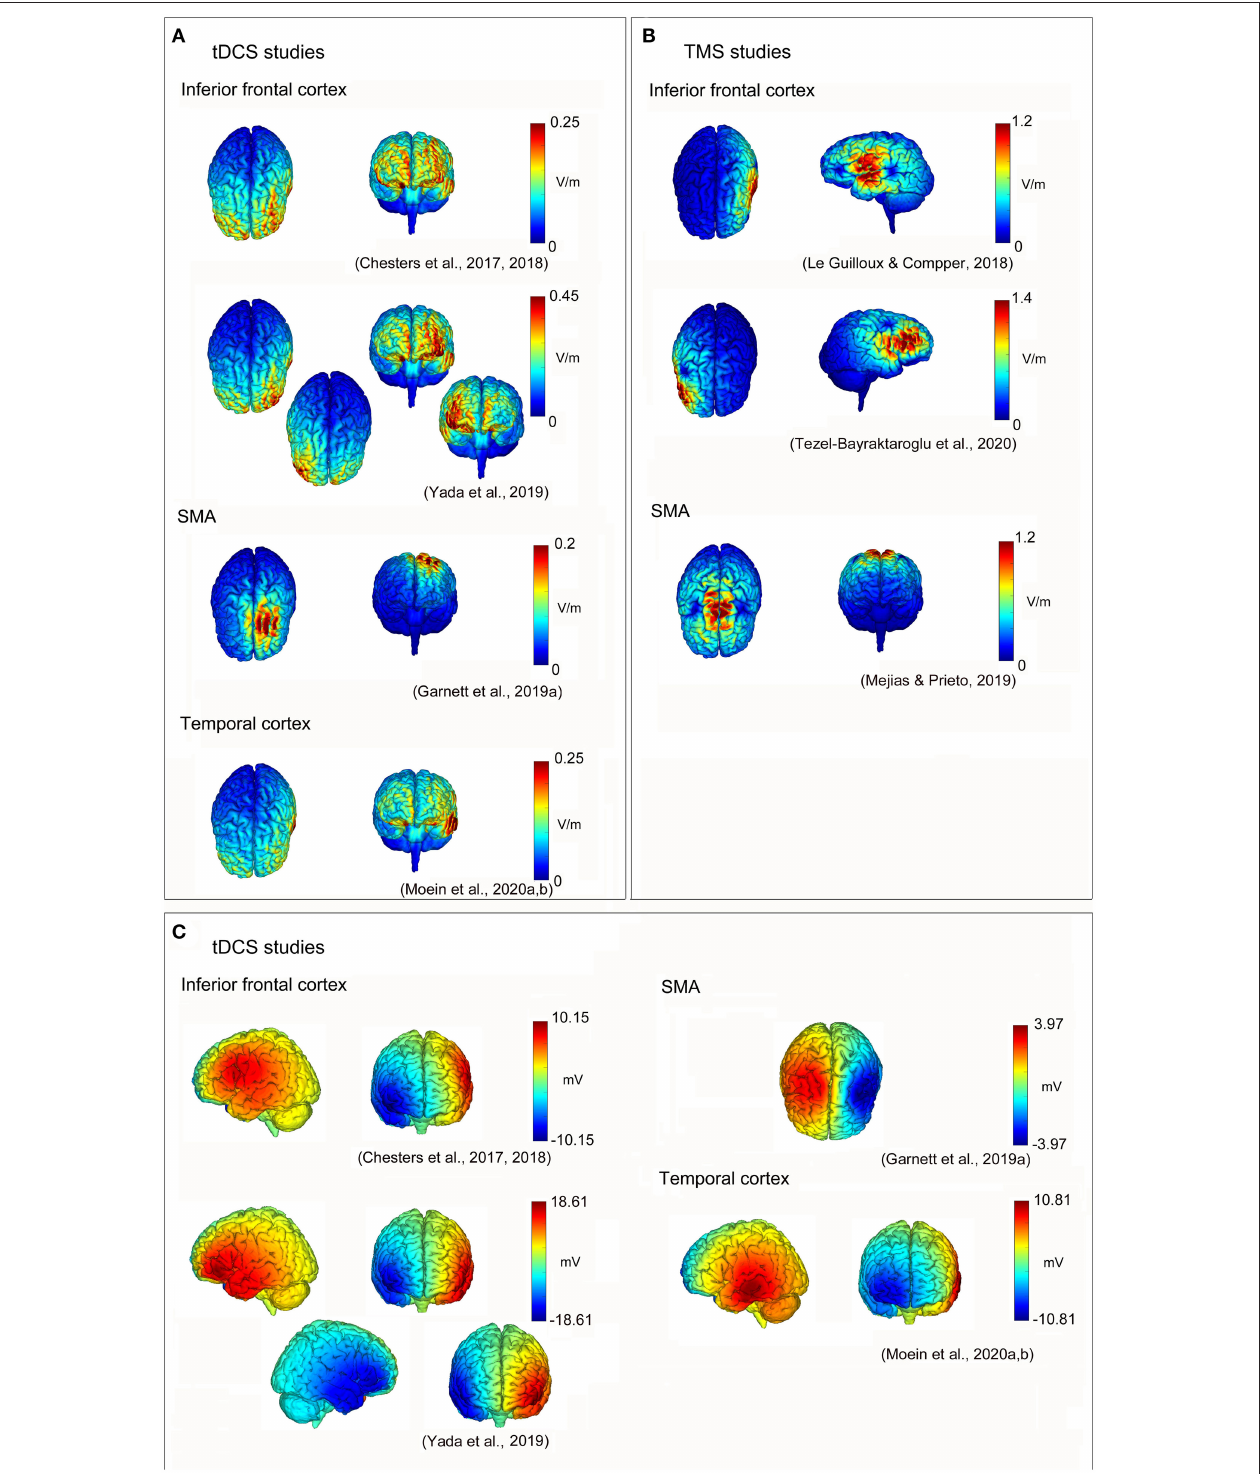
FIGURE 1 | Non-invasive brain stimulation (NIBS) neuromodulation in developmental stuttering (DS) to improve speech fluency. Reconstructions of electric field strengths for every reviewed study: (A) absolute values of the electric fields of transcranial direct current stimulation (tDCS) studies estimated using “SimNIBS” (Thielscher et al., 2015; https://simnibs.github.io/simnibs/build/html/index.html); (B) absolute values of the electric fields of transcranial magnetic stimulation (TMS) studies estimated using “SimNIBS” (Thielscher et al., 2015; https://simnibs.github.io/simnibs/build/html/index.html); and (C) positive (red) and negative (blue) values of the electric fields of tDCS studies estimated using “NIC2” (Neuroelectrics, Barcelona, Spain).